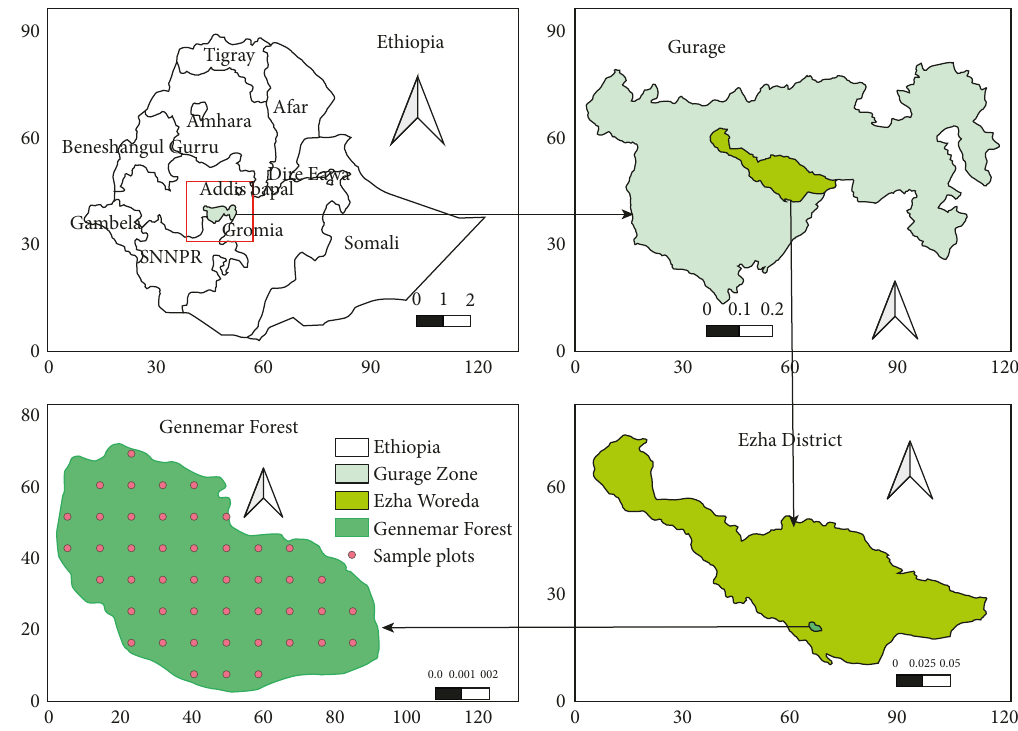
Figure 1: Map of study area in relation to the maps of the district, zone and